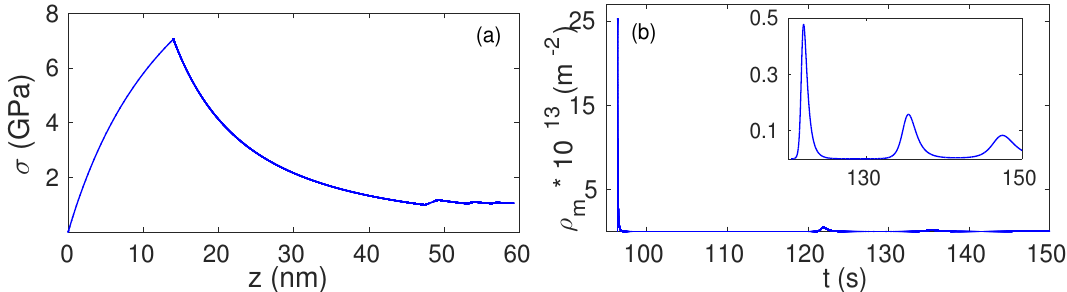
Figure 8. ( a ) Plot of stress as a function of z corresponding to the ( 110 ) orientation corresponding to Figure 4a; ( b ) plot of ρ m as a function of time corresponding to Figure 4a. The inset in ( b ) shows secondary bursts on an expanded scale. Note that the first burst of ρ m is nearly 50 times the second, after